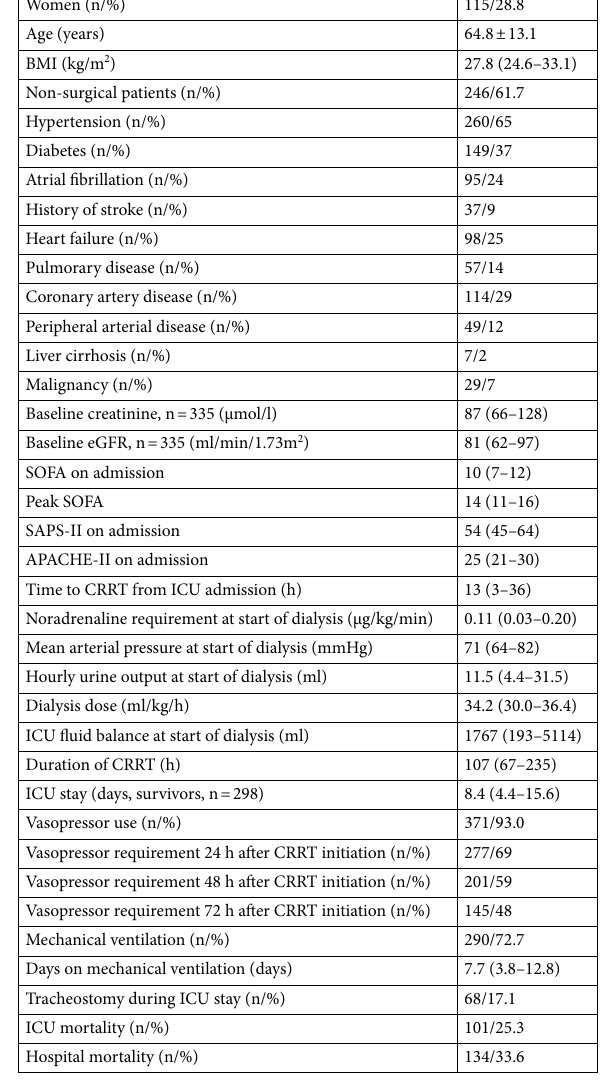
Assessment Score, SAPS-II Simplified Acute Physiology Score, APACHE-II Acute Physiology and Chronic Health Evaluation Score II, CRRT Continuous Renal Replacement Therapy, ICU Intensive Care